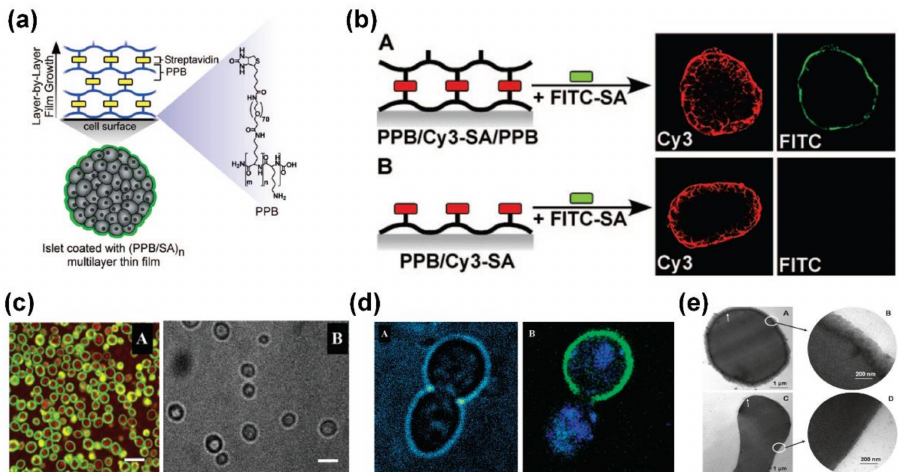
Figure 4. ( a ) Schematic illustration of the fabrication of PEG-rich, nanothin conformal islet nanofilms via LbL assembly; ( b ) Poly( L -lysine)- g -poly(ethylene glycol)(biotin)/streptavidin multilayer films assembled on individual pancreatic islets; ( c ) confocal images of freshly coated living cells and ( d ) transmission image of cells during their duplicating process; ( e ) transmission electron microscope images of coated and uncoated red blood cells with LbL assembly films. Reprinted from [82,84,85] with permissions from American Chemical